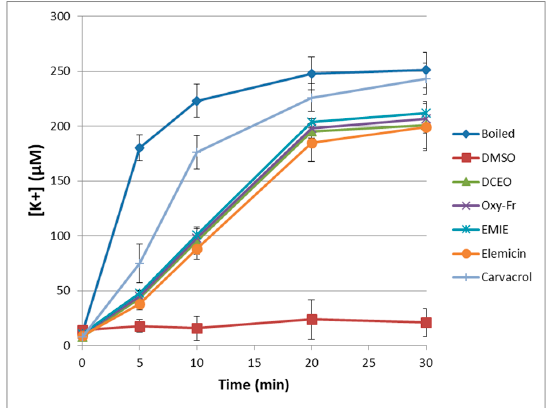
Figure 3. Extracellular potassium level measured by flame emission spectroscopy after treatment with DCEO, oxygenated fraction and purified active molecules. Data are the means ± SEM from three independent experiments.